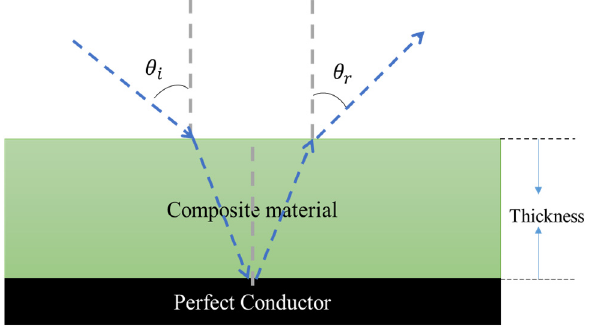
Figure 10. Schematic illustration of electromagnetic wave propagation through the composite material. According to the theory of the transmission line, the reflection loss of